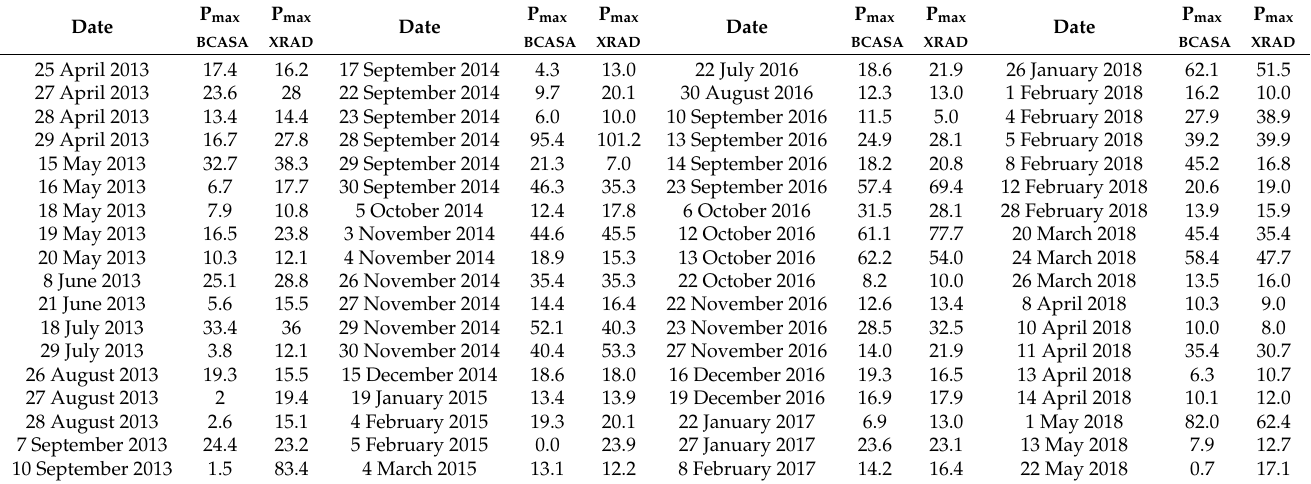
Table A1. List of the 207 rainfall episodes inside ROI resulting from the combination of XRAD and BCASA